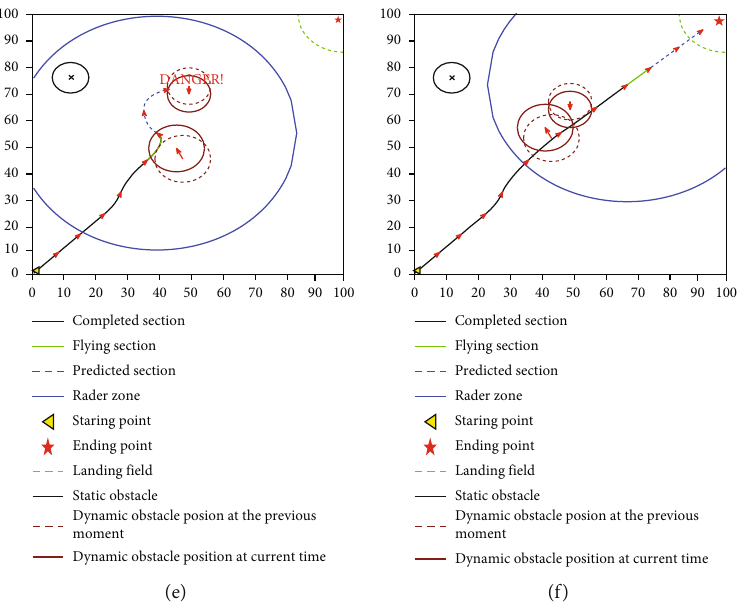
Figure 14: Crossover and variation path planning results. Table 6: Crossing and variation test